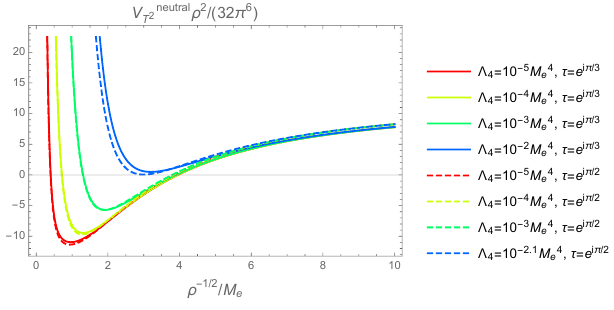
Figure 11 . U(1) gauge theory with neutral matter. The potential as a function of (cid:26) , the volume of T 2 .